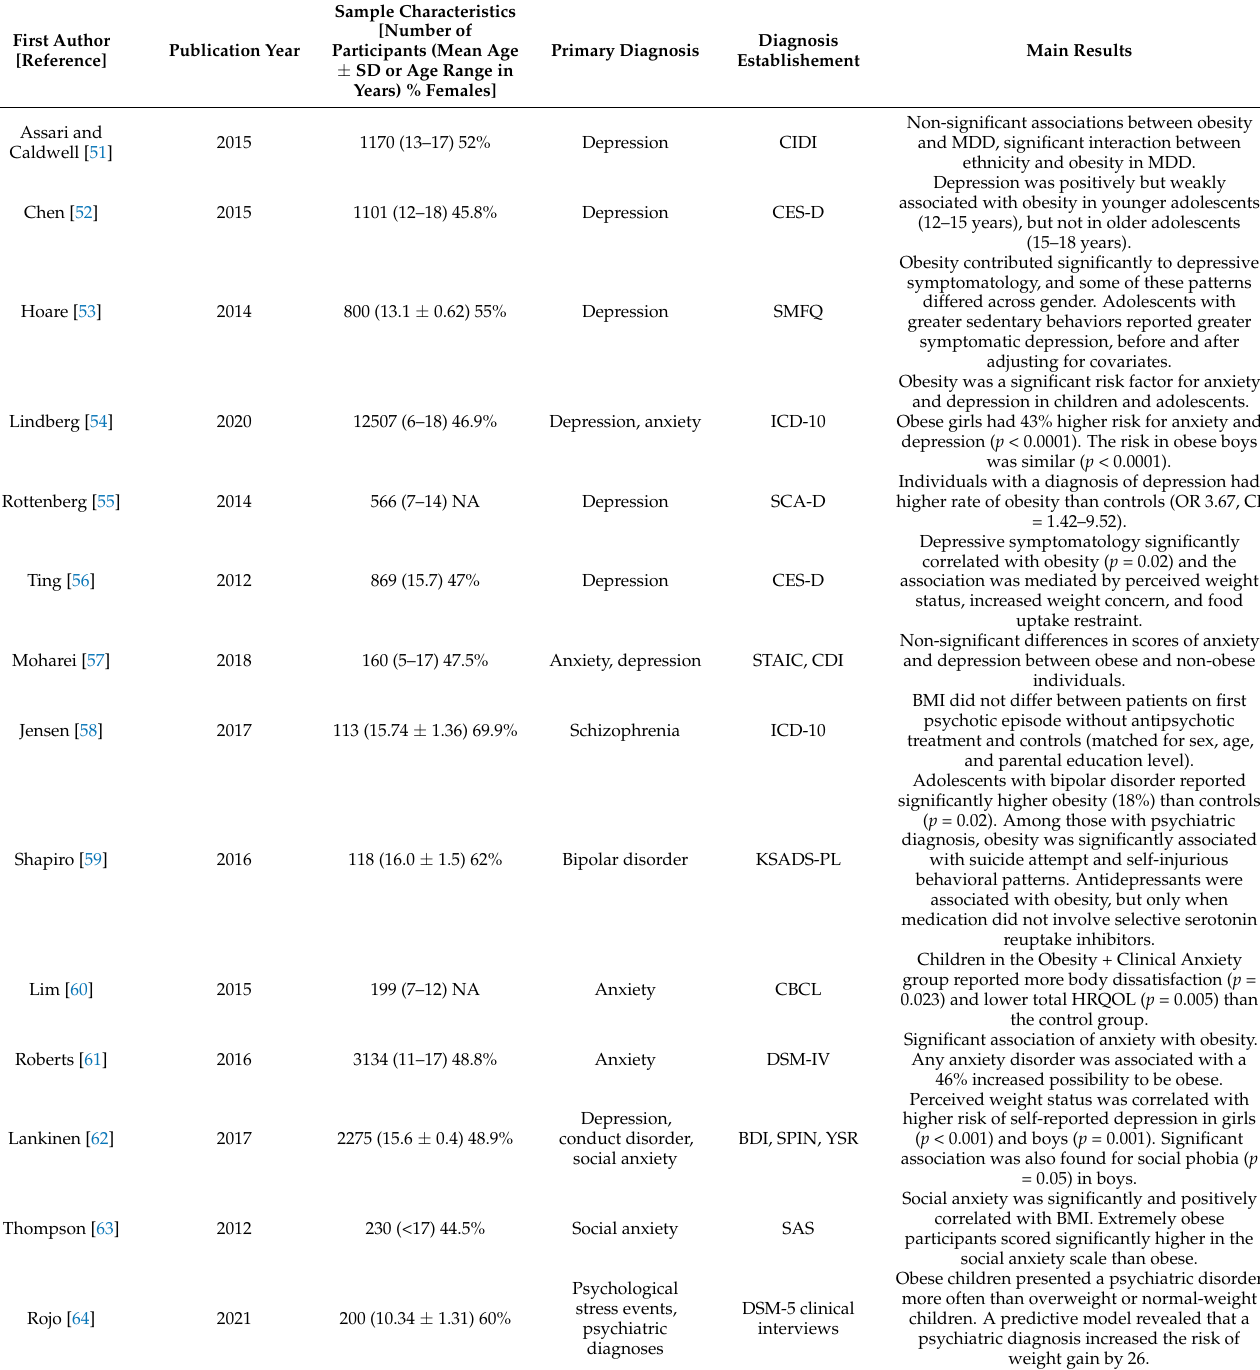
Table 1. Basic characteristics of the included